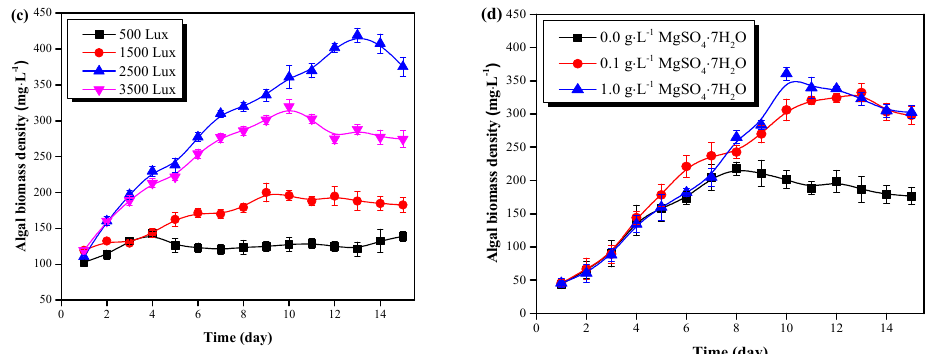
Figure 2. C. vulgaris growth results in the pretreated pig urine. (a) The effect of pig urine dilution rate on the microalgal growth. (b) The effect of pig urine pH value on the microalgal growth. (c) The effect of light intensity on the microalgal growth. (d) The effect of pig urine MgSO 4 ∙ 7H 2 O dosage on the microalgal growth.